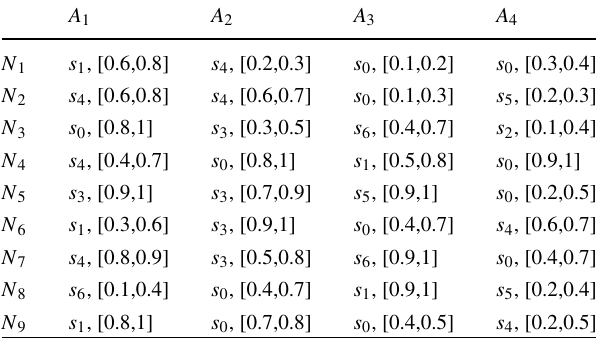
Table 3 The decision matrix with confidence interval values according to the second voting node